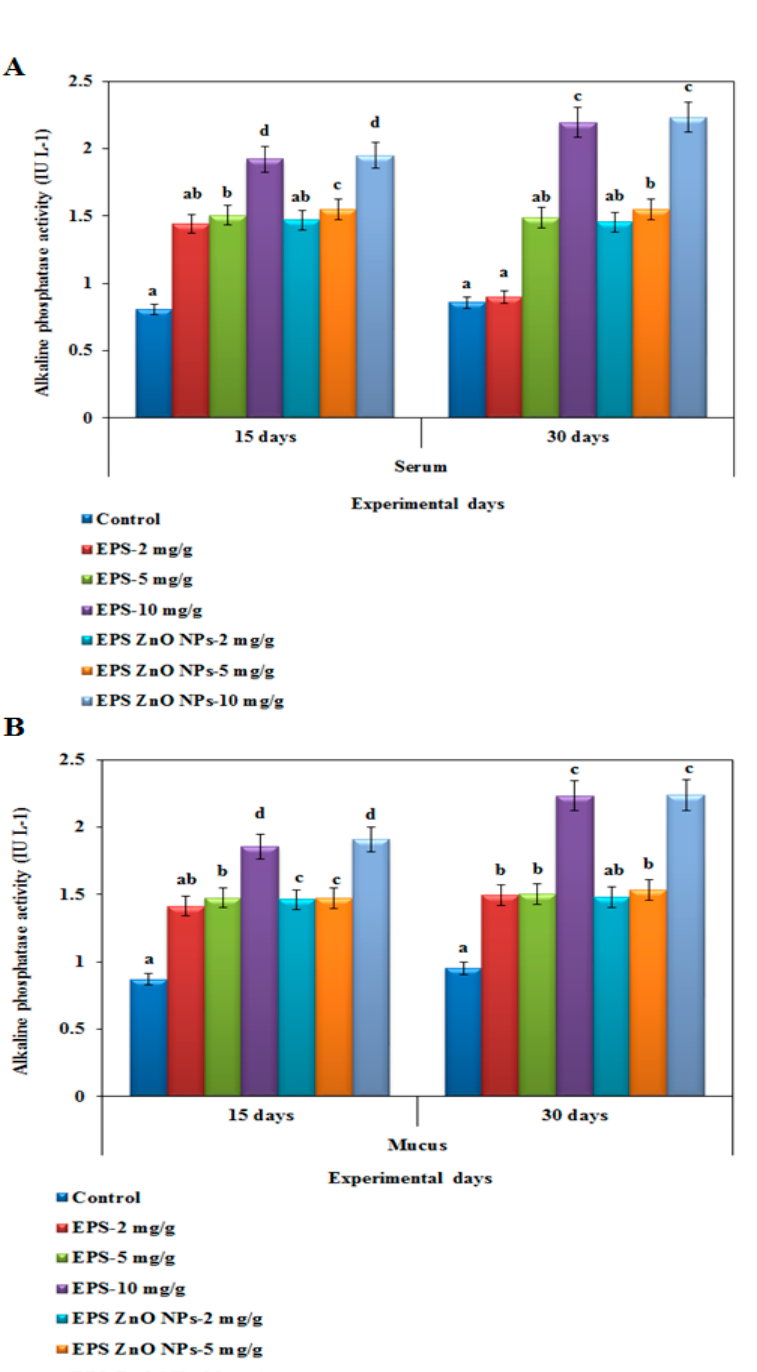
Figure 6. Alkaline phosphatase activity of O. mossambicus fed with EPS and EPS-ZnO NPs: ( A ) serum and ( B ) mucus. T-bars indicate three replicates of mean ± SD, and different letters correspond to the statistical difference between treated groups.